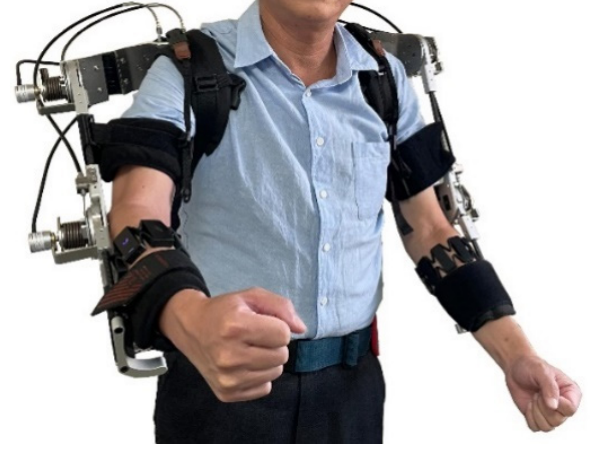
Figure 2. Photograph of the designed WURAES.